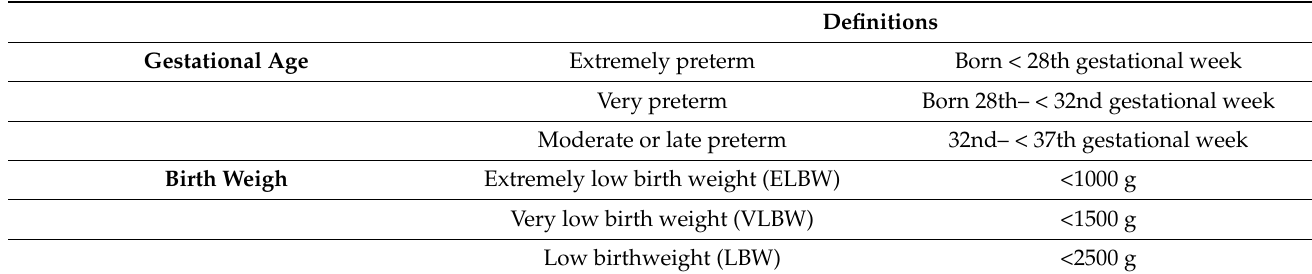
Table 1. Definition of preterm and low birth weight